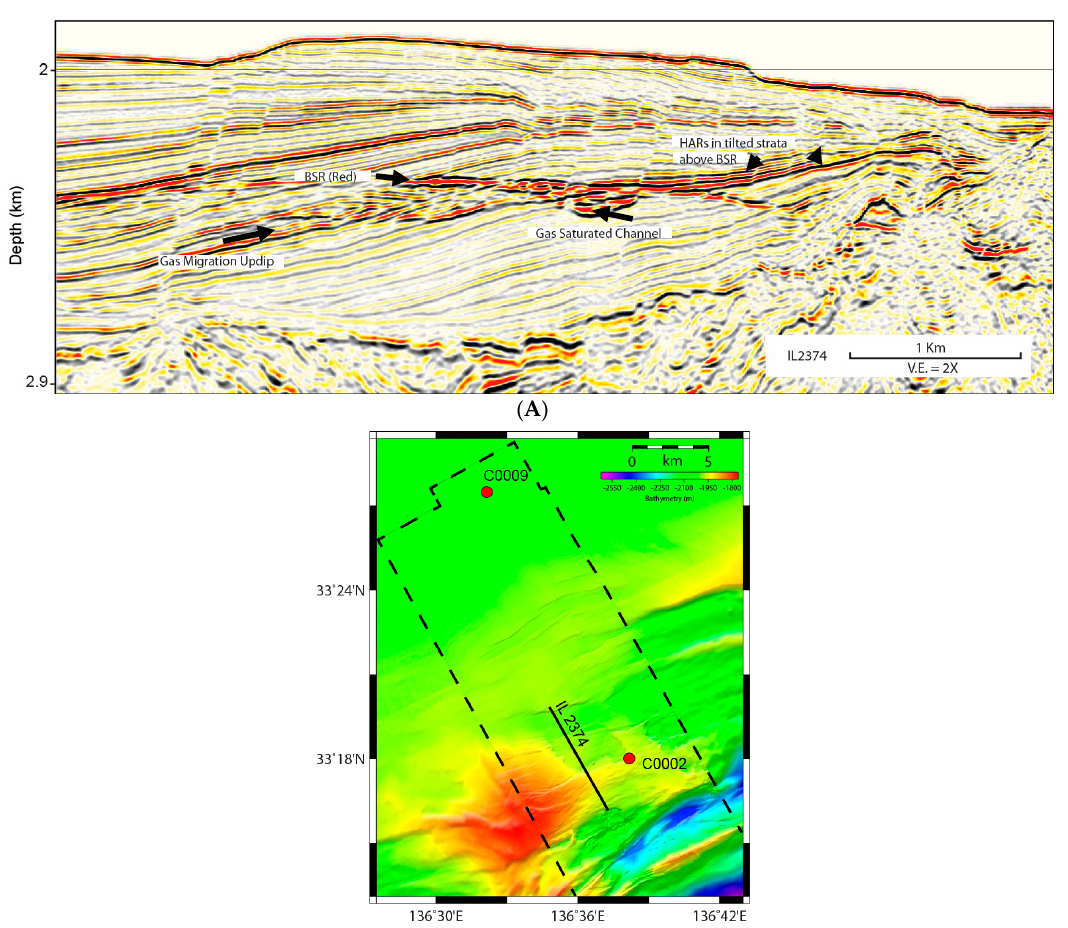
Figure 8. ( A ) Inline 2374 showing HARs beneath the BSR correlates with Site C0002 gas-charged Zone-B (Figure 3). Strong HARs within the erosional channel feature are interpreted to be gas saturated sands. A strong BSR is observed. HARs above the BSR in tilted strata likely indicate high GH saturation. ( B ) Bathymetric map of the study zone with the extent of IL 2374 shown for reference.